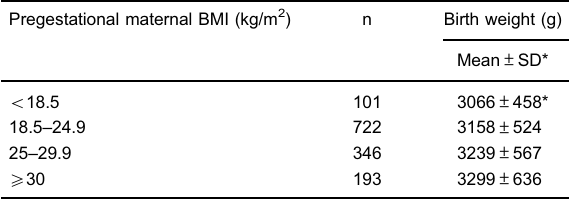
Table 3. Birth weight according to maternal pregestational BMI. BRISA Cohort, Ribeirão Preto, 2010. Pregestational maternal BMI (kg/m 2